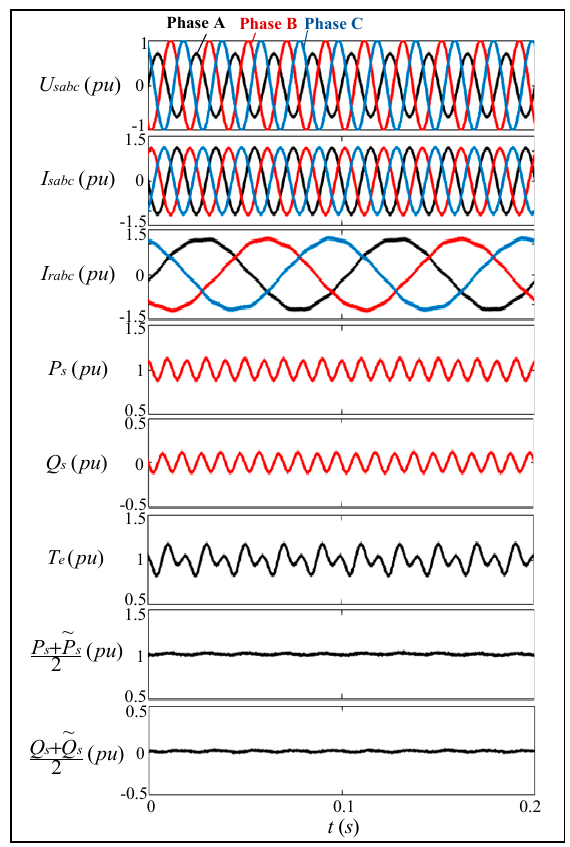
Figure 8. Proposed VSG control under a single-phase grid voltage drop of 30% (Target 2). Energies 2020 , 12 , x FOR PEER REVIEW